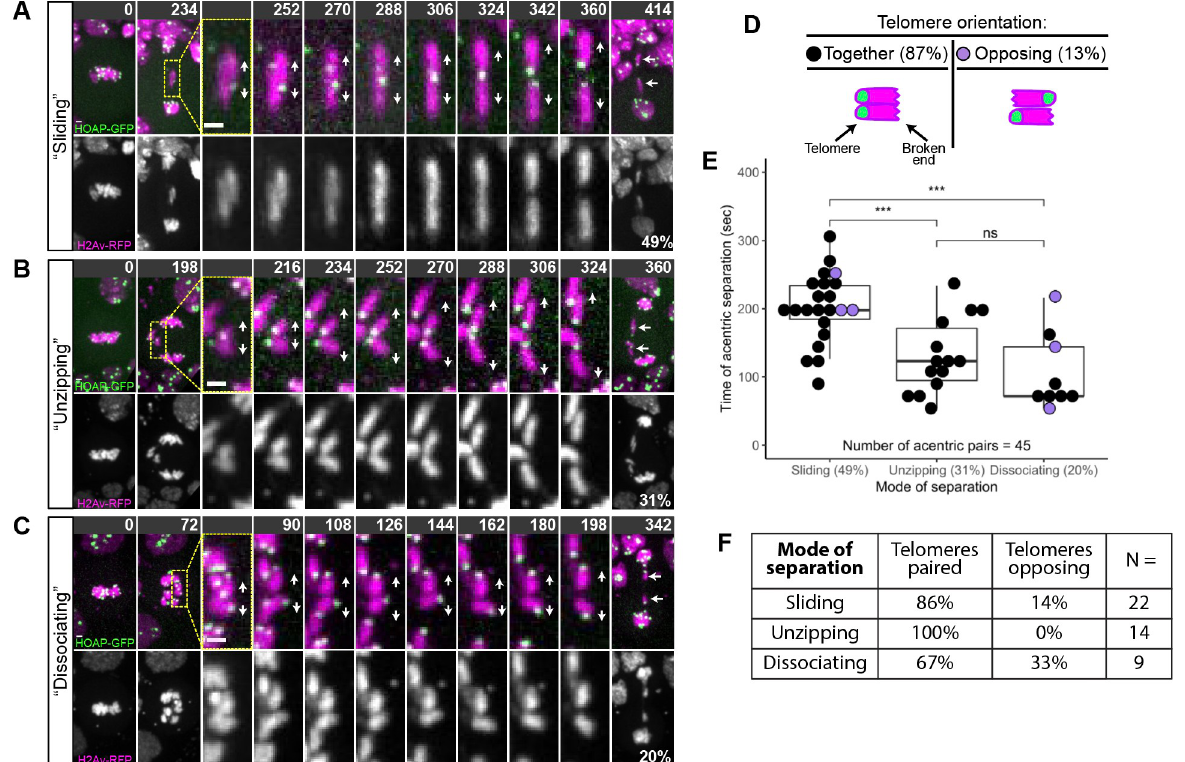
Fig 3. Sister acentrics separate via three distinct patterns. Chromosomes labeled with H2Av-RFP (magenta) and telomeres labeled with HOAP-GFP (green). Telomeres indicated by yellow arrowheads. Direction of separation indicated by white arrows. (A) Top row: Still images of a time-lapse movie of a mitotic neuroblast with I-CreI induced acentrics showing sister acentrics (cyan arrows) lagging behind during anaphase, paired with telomeres opposing, sliding past one another, and ultimately separating. Bottom row: Black and white images of sister acentrics sliding past one another (see arrows) (S2 Data). (B) Top row: Still images of a time-lapse movie of a mitotic neuroblast with I-CreI induced acentrics showing acentrics (cyan arrows) lagging on the metaphase plate. In a process we term “unzipping”, sister acentrics are aligned with telomeres paired, initiate separation at their broken ends followed by separation of telomeres. Bottom row: Black and white images of sister acentrics unzipping (see arrows). (C) Top row: Still images of a time- lapse movie of a mitotic neuroblast with I-CreI induced acentrics showing sister acentrics (cyan arrows) lagging behind during anaphase. In a process we term “simultaneous dissociation”, sister acentrics simultaneously separate along their entire length. Bottom row: Black and white images of sister acentrics simultaneously separating along their entire lengths (see arrows). (D) Frequency of acentric sisters paired with their telomeres aligned or in opposite orientations. (E) Measurements of the frequency of each mode of acentric sister separation (x-axis) and the timing of acentric sister separation after intact chromosomes separate (y-axis). Each dot represents on acentric pair. Black dots represent acentric sisters with telomeres aligned and purple dots represent acentric sisters with telomeres oriented in opposite directions. Boxes show interquartile ranges and lines show medians of the measured data. Asterisks represent statistical significance ( ��� P = 0.0008) determined by two-sided Mann-Whitney tests. (F) Chart showing the distribution of telomere orientations within each mode of acentric sister separation. Acentrics that separate by unzipping are always oriented with their telomeres